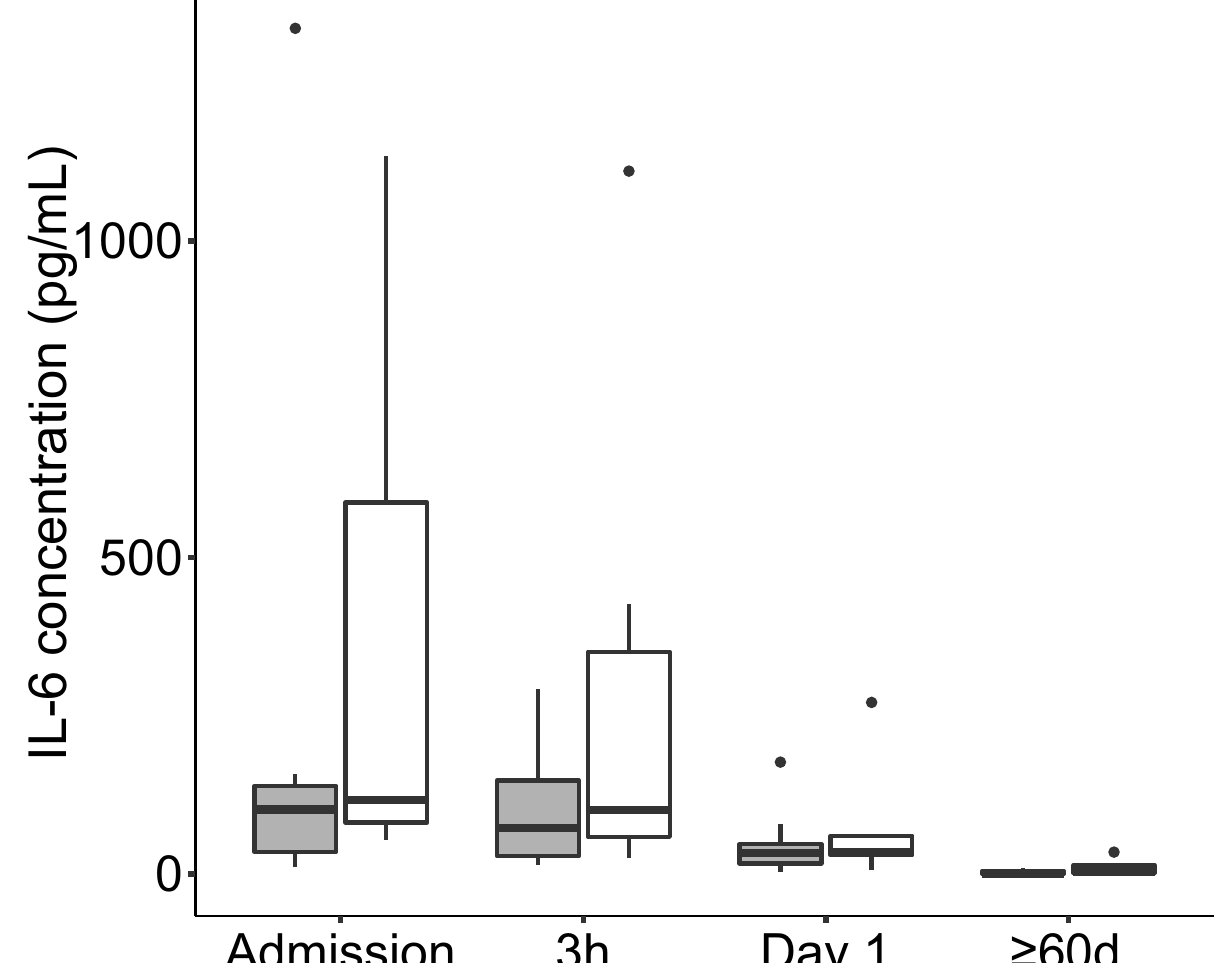
Fig 10. Boxplot diagram depicting variability and concentration per time point of IL-6 divided by gender. Outliers are shown as dots. Females are shown in gray boxes and males in white boxes. https://doi.org/10.1371/journal.pone.0216379.g010 Table 7. Correlation between LPC and cytokine concentrations. Cytokine a Spearman’s correlation r with total LPC (P-value b )